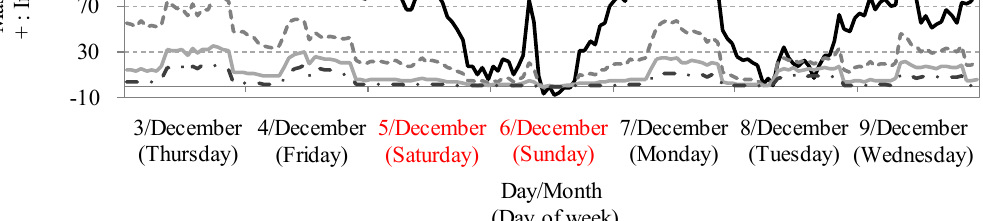
Figure 9. Mass flow rate of infiltration in the sixth floor of the east staircase (3 December–9 December). Energies 2016 , 9 , 875